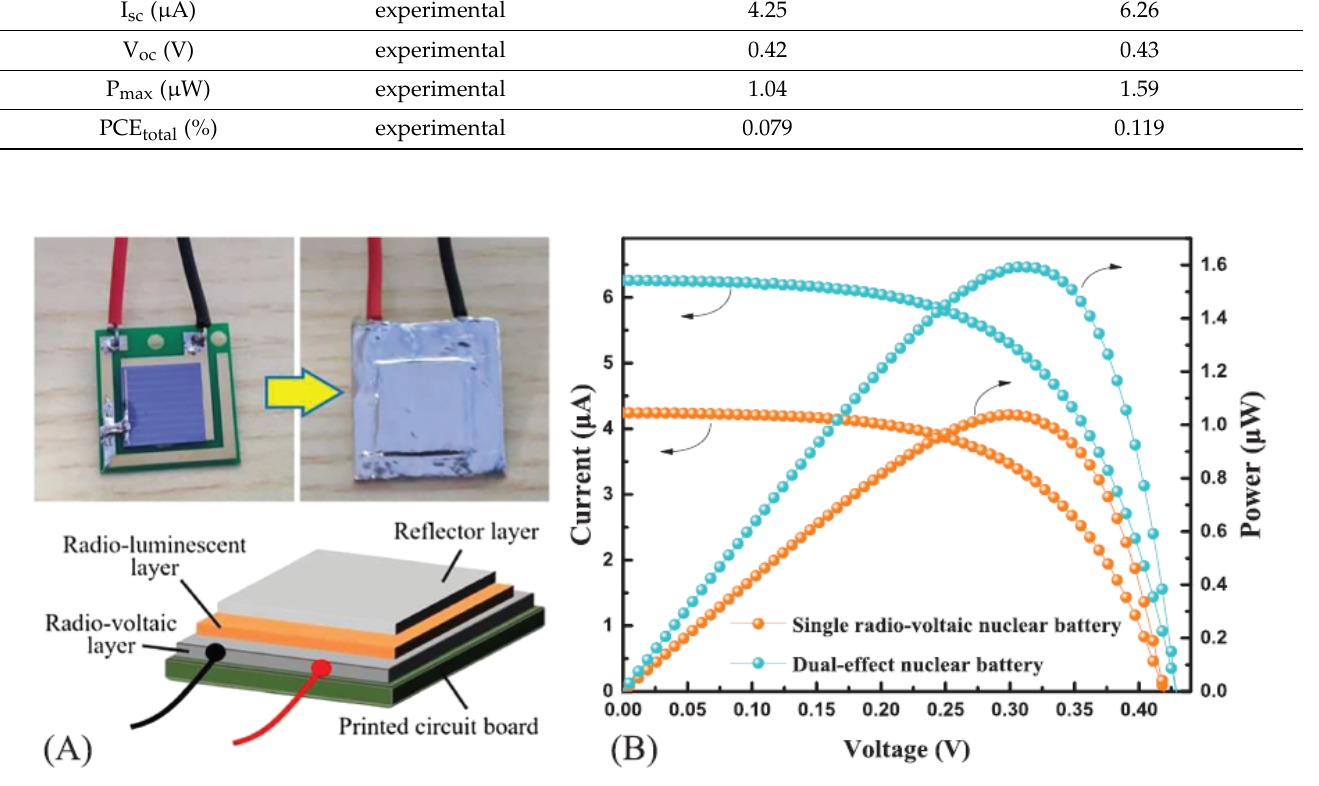
Figure 12. ( A ) Nuclear battery samples and structure schematic; ( B ) I − V and P − V characteristic curves of nuclear battery before and after performance enhancement. Copyright permission from [132].